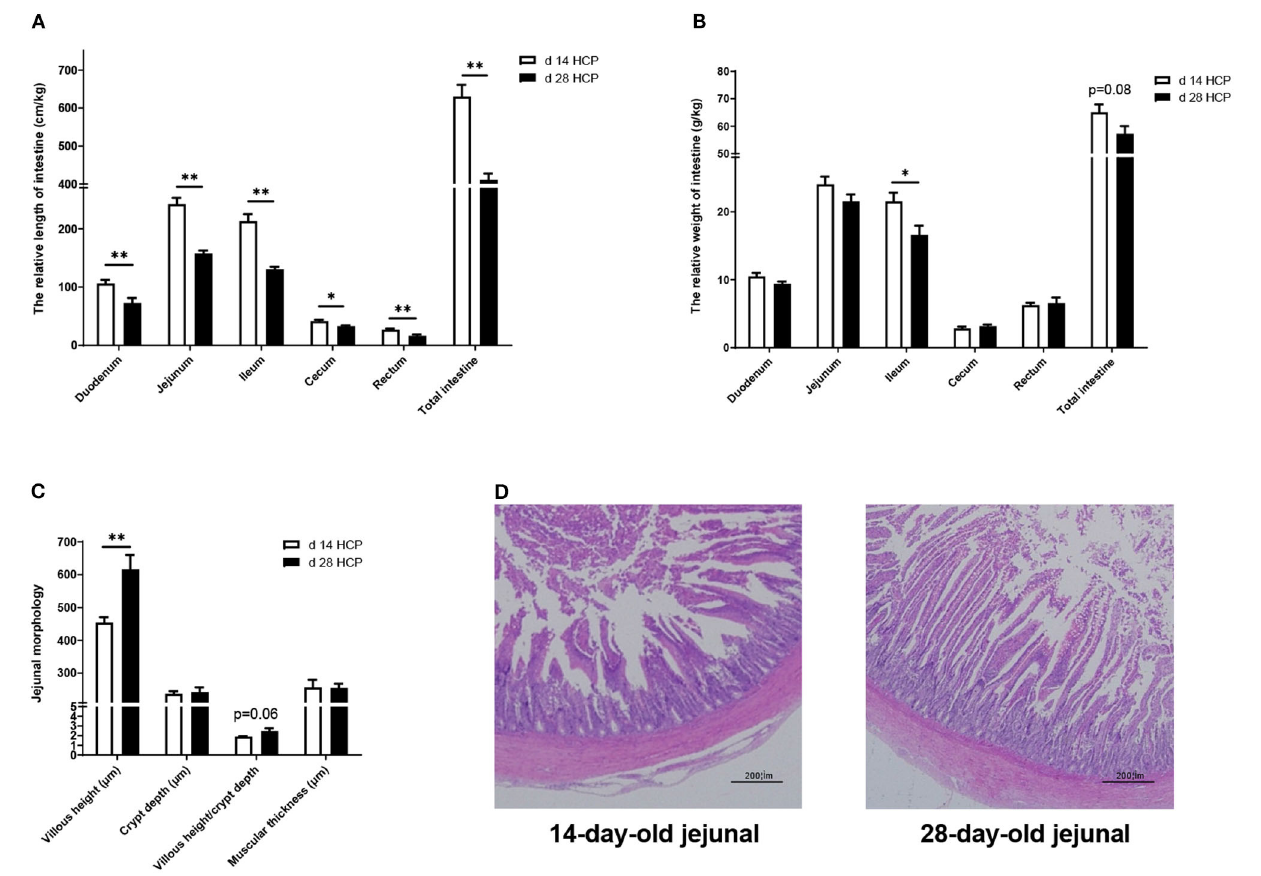
FIGURE 5 | Effect of HPC meal-based diet on gut development of Magang geese on d 14 and d 28. (A) The relative length of intestine. (B) The relative weight of intestine. (C) Jejunal morphology. (D) Jejunal morphology of d 14 and d 28 HCP. *mean significant difference (p < 0.05) and **mean extremely significant difference (p < 0.01). The image was taken at magnification of 20 × , scale bar, 200 µ m.